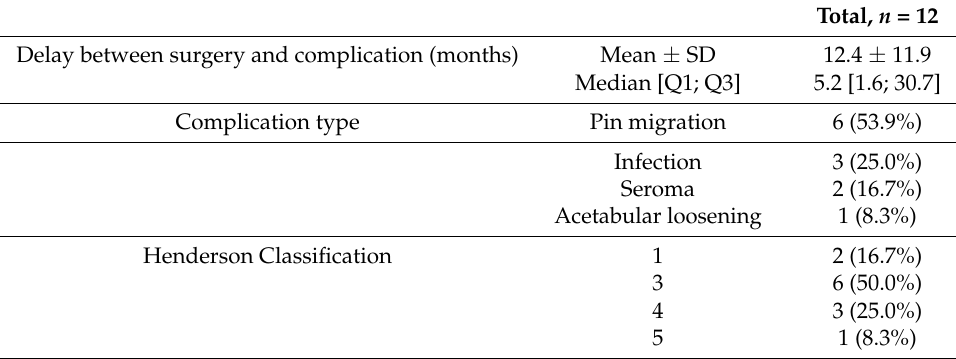
Table 3. Description of the complications.